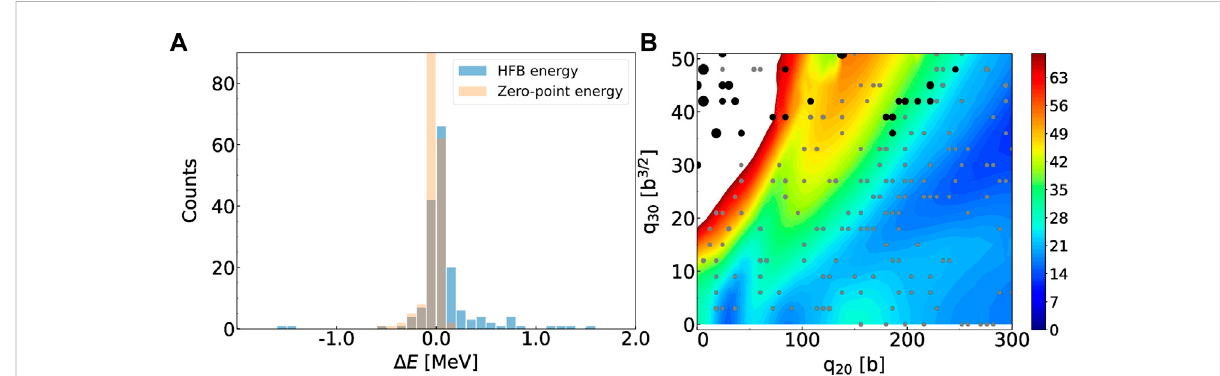
FIGURE 2 (A) : Histogram of the error on the GP-predicted total HFB energy and zero-point energy correction across the validation points. Bin size is 100 keV. (B) : Size of the error on the GP-predicted total HFB energy across the validation set. Gray circles have an error lower than 500 keV and the sizeofthemarkerscorrespondtoenergybinsof100 keV.Blackcircleshaveanerrorgreaterthan500 keVandarebinnedby400 keVunits.Energies indicated by the color bar are in MeV relatively to − 1820 MeV.